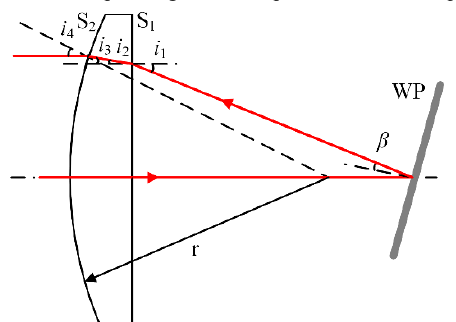
Figure 3. Schematic of the light propagation in the plano- convex lens: r is lens surface radius, WP - waveplate with reflective layer; S 1 and S 2 – surface of the